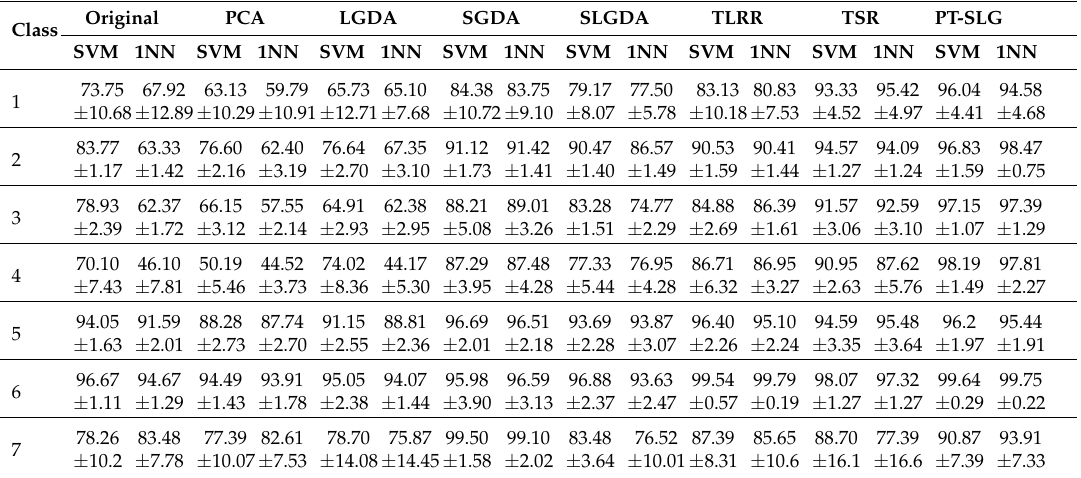
Table 1. Classification results on the Indian Pines dataset (Reduction Dimensionality =